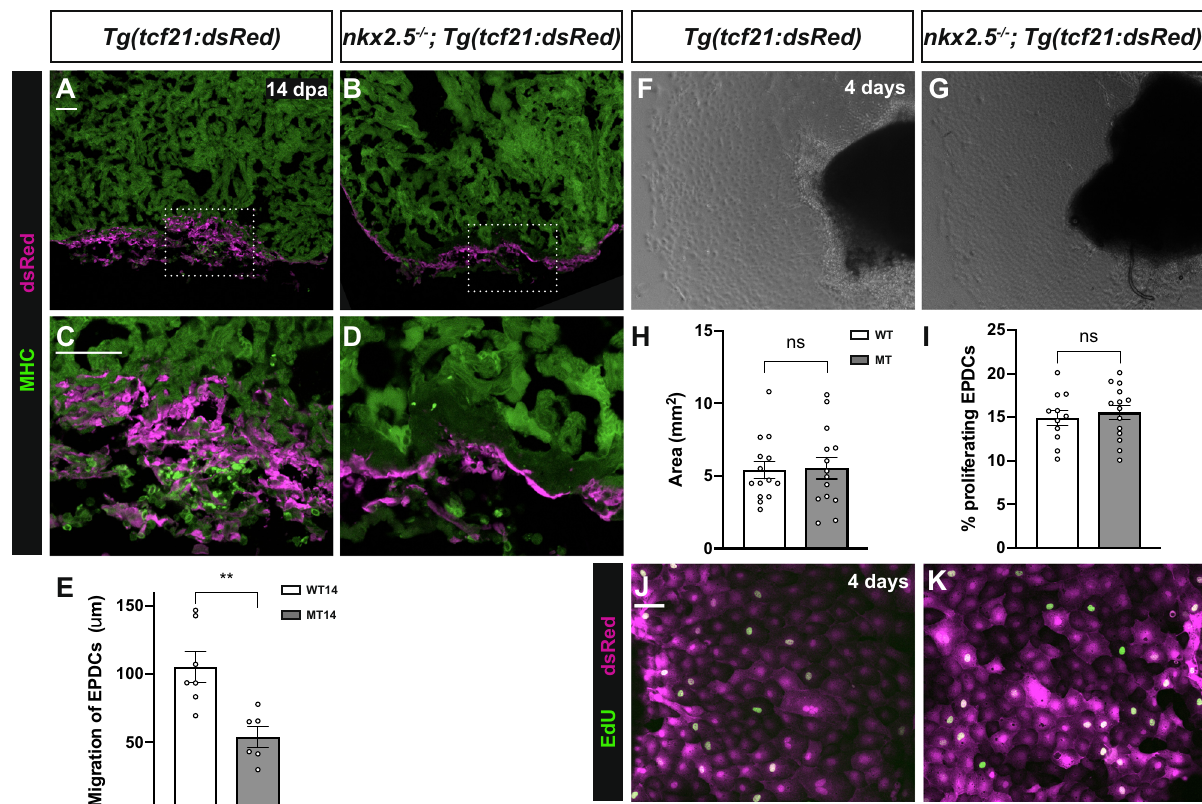
Fig. 9 Impaired epicardial migration in the nkx2.5 loss-of-function model. A – D Myosin Heavy Chain (MHC) immunostaining in injured Tg(tcf21:dsRed) ( n = 6) ( A , C ) and nkx2.5 − / − ;Tg(hsp70l:nkx2.5-EGFP);Tg(tcf21:dsRed) ( n = 5) ( B , D ) at 14 dpa exhibits aborted epicardial penetration in the nkx2.5 − / − heart. Scale bar, 50 μ m. E EPDC migration quanti fi cation strategy measures the distance from the apex of the heart to the maximal interior position of the Tcf21:DsRed2 + cells in injured wild-type ( n = 6) and nkx2.5 − / − ( n = 5) hearts ( A – D ). Mean and standard error of each data set are shown. Unpaired, two- tailed t -test demonstrates a statistically signi fi cant difference between WT14 and MT14 ( p = 0.0035). F , G Ex vivo epicardial migration assay in Tg(tcf21:dsRed) ( n = 14) ( G ) and nkx2.5 − / − ;Tg(hsp70l:nkx2.5-EGFP);Tg(tcf21:dsRed) ( n = 14) ( H ) explants. H , I Quanti fi cation of the epicardial migration showing no statistical difference between the wild-type ( n = 14) and the nkx2.5 − / − ( n = 14) cultured apices ( F , G ). Additional quanti fi cation of Edu + tcf21:dsRed + cells indicates normal proliferative potential in cultured nkx2.5 − / − ( n = 14) versus wild-type epicardium ( n = 12) ( J , K ). Mean and standard error of each data set are shown with no statistically signi fi cant differences detected by unpaired, two-tailed t -tests between WT and MT ( p = 0.8794 in H and p = 0.6165 in I ). J , K Edu proliferation assay in wild-type ( n = 12) ( K ) and nkx2.5 − / − ( n = 14) ( L ) epicardial tcf21:dsRed + cells. Scale bar, 50 μ m. Source data are provided as a Source Data fi